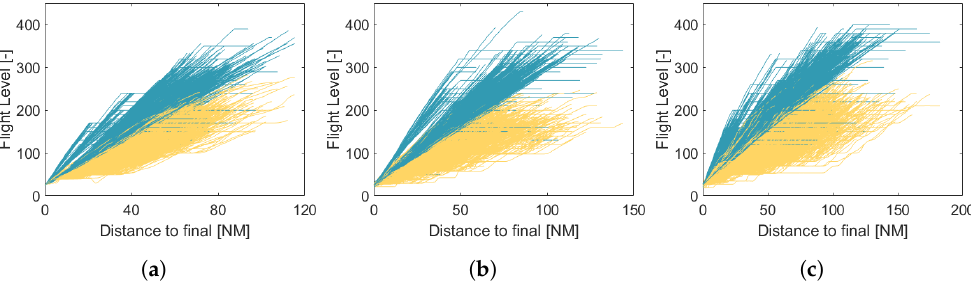
Figure 3. Vertical profiles of the actual trajectories (in yellow) and the corresponding reference continuous descent operations (CDOs) (in turquoise) for Arlanda ( a ), Vienna ( b ) and Dublin ( c